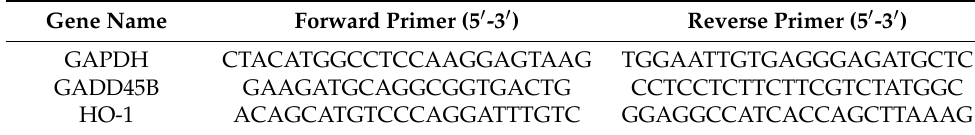
Table 1. Forward and reverse primers of the selected